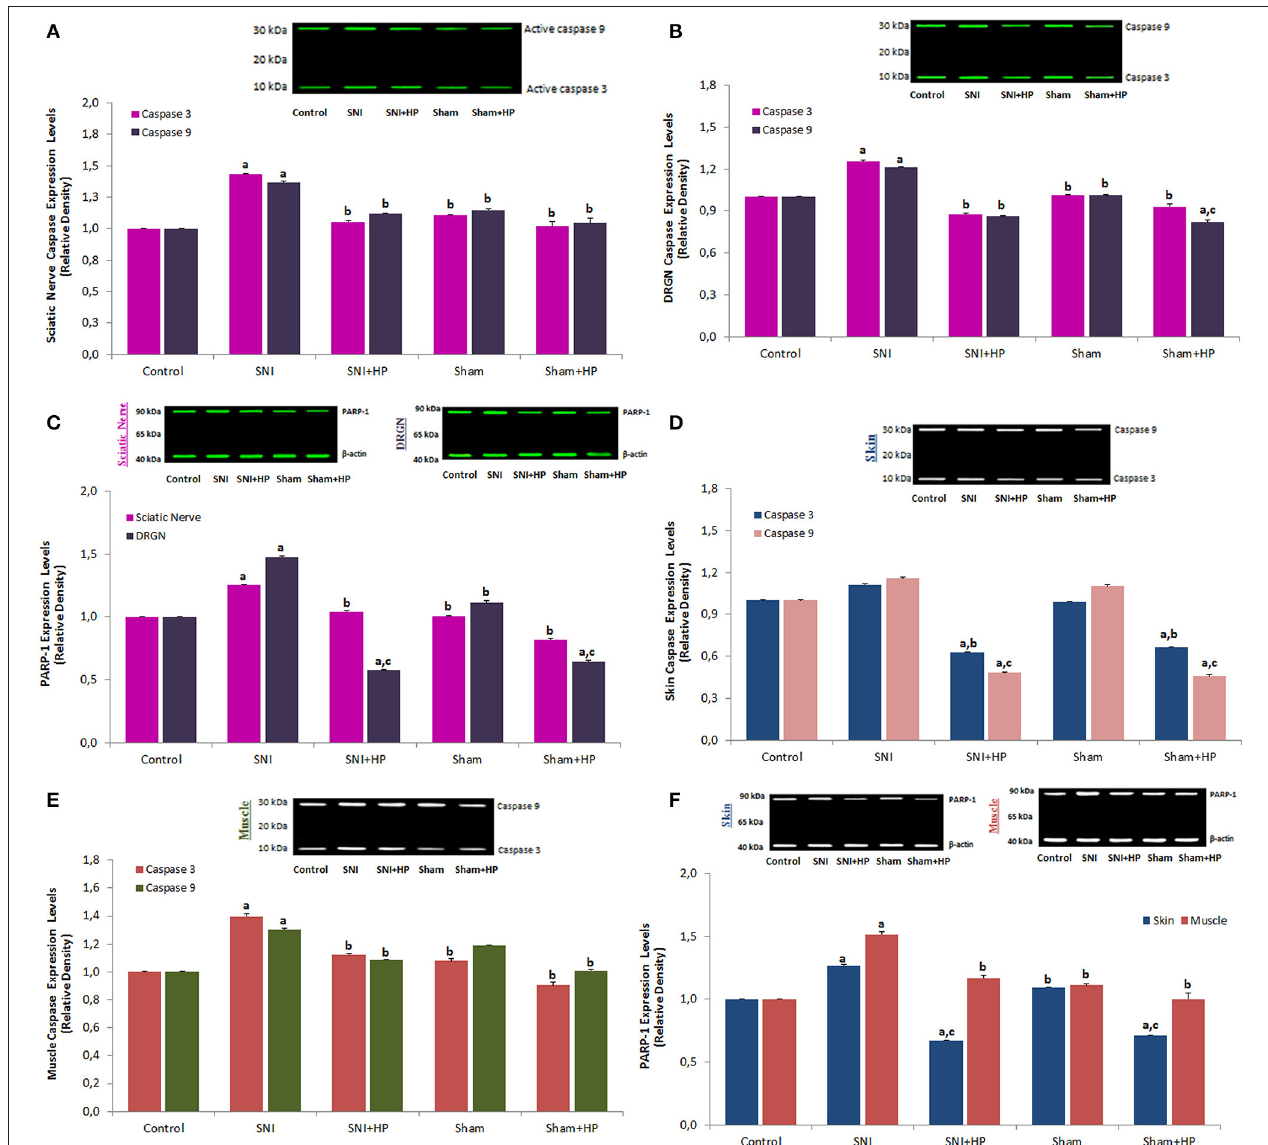
FIGURE 8 | Effects of Hypericum perforatum (HP) on the PARP-1, caspase 3 and 9 expression levels in sciatic nerve (A,C), DRGN (B,C) , skin (D,F) and muscle (Musculus piriformis) (E,F) and skin (F) of rats with SNI (mean ± SD and n = 3). Anti- β -actin was used as an internal control for the concentration of PARP1, caspase 3 and 9. Values expressed as fold increase (experimental/control). Sciatic nerve DRGN neurons were dissected from control, SNI and HP treated animals. ( a p ≤ 0.05 vs. control, sham, sham + HP groups. b p ≤ 0.05 and c p ≤ 0.001 vs. SNI group).